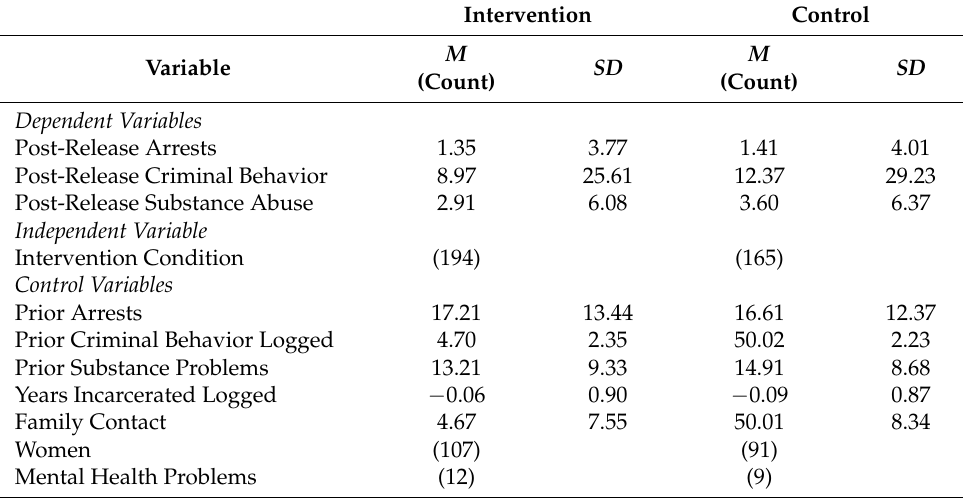
Table 1. Descriptive statistics.